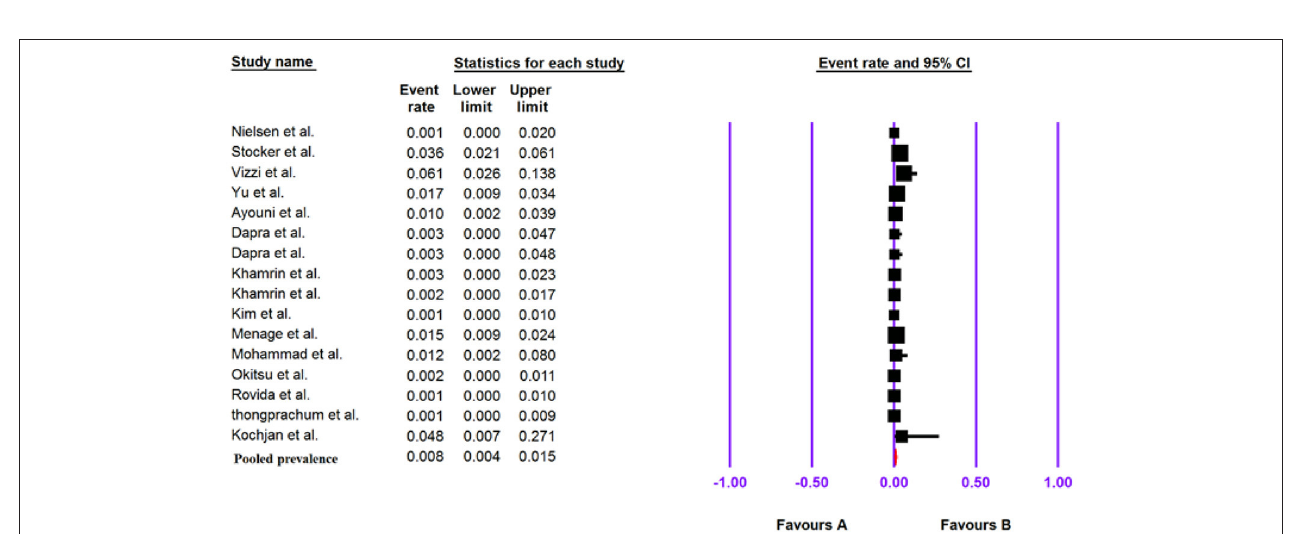
FIGURE 6 | Forest plot of the pooled prevalence for HCosV.